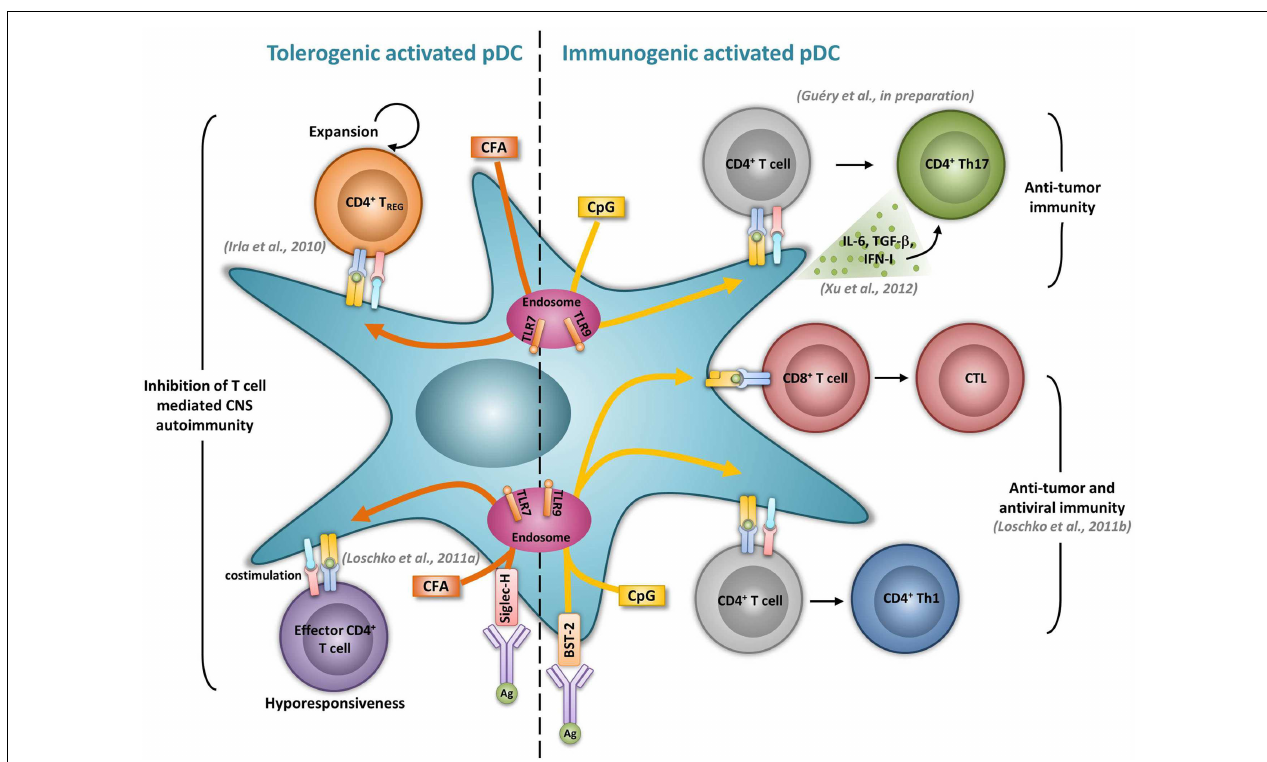
FIGURE 1 |Activated pDCs induce dual tolerogenic and immunogenicT cell responses. The most relevant in vivo experimental animal systems are represented in this figure.